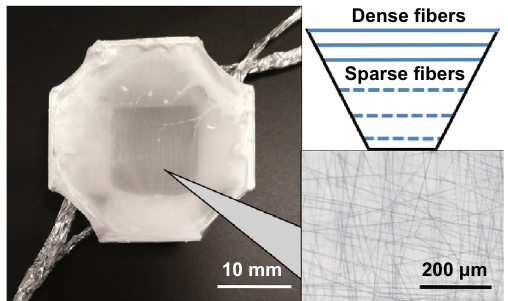
Fig. 8 A mesh-structure scaffold fabricated by the four-bevel